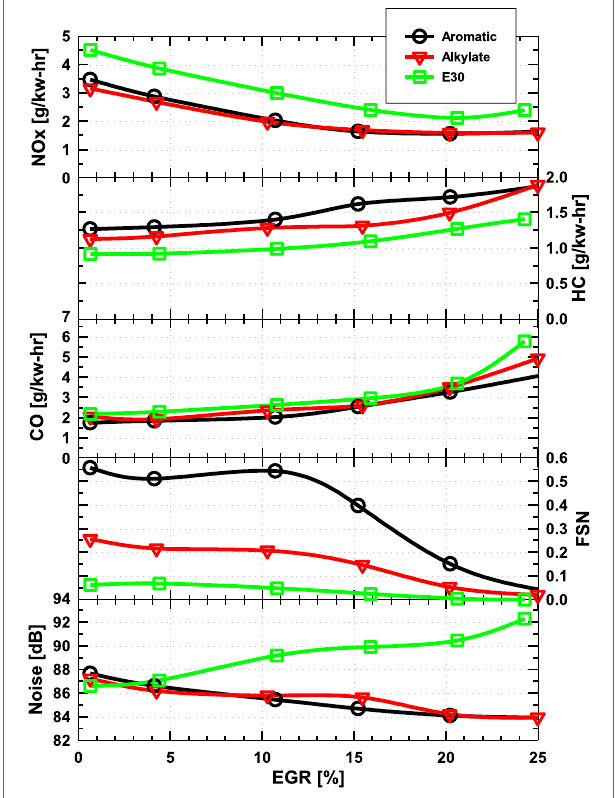
FigUre 4 | Exhaust gas recirculating (EGR) sweep (0–25%) results with start of injection adjustment of second injection for constant combustion phasing: emission of (NOx, HC, and CO); filter smoke number (FSN); and combustion